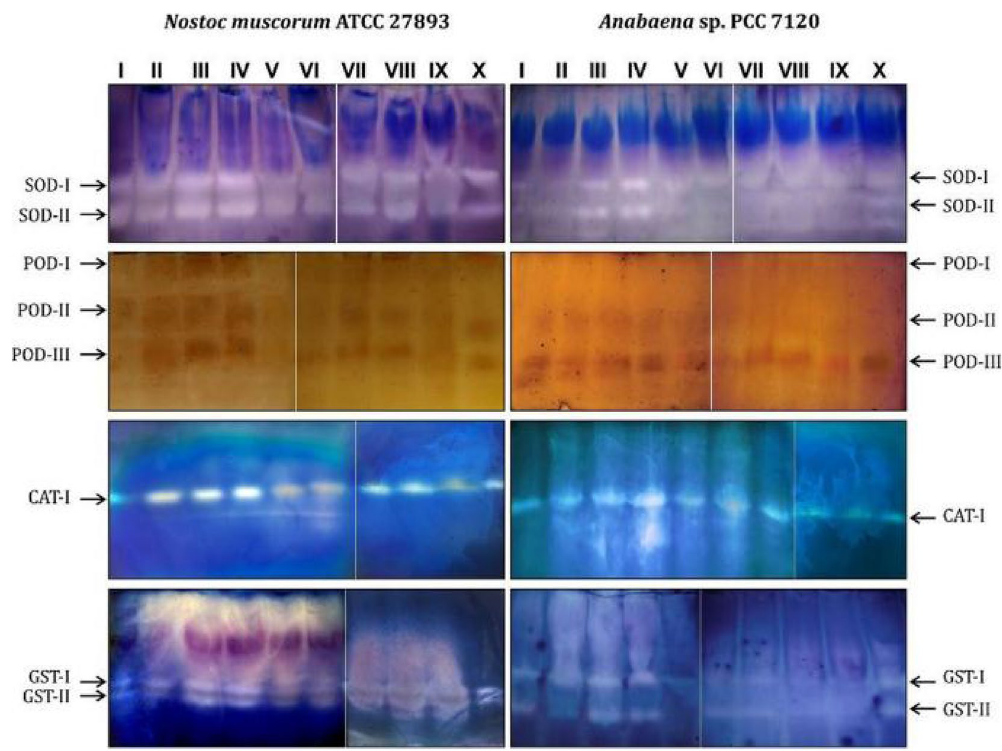
Figure 6. Isoenzymes profiling of SOD, POD, CAT and GST in H 2 O 2 and NO (SNP) treated Nostoc muscorum ATCC 27893 and Anabaena sp PCC 7120 exposed to Cd stress. For the determination of isoenzyme activity, 300 μg proteins from cell extracts were loaded into the wells of native PAGE; where lane I: Control, lane II: Cd, lane III: Cd + H 2 O 2 , lane IV: Cd + SNP, lane V: Cd + H 2 O 2 + PTIO, lane VI: Cd + H 2 O 2 + L NAME, lane VII: Cd + SNP + NAC, lane VIII: Cd + SNP + DPI, lane IX: Cd + H 2 O 2 + SNP + PTIO + L NAME, lane X: Cd + H 2 O 2 + SNP + NAC + DPI; full length gels are presented in supplementary Fig.